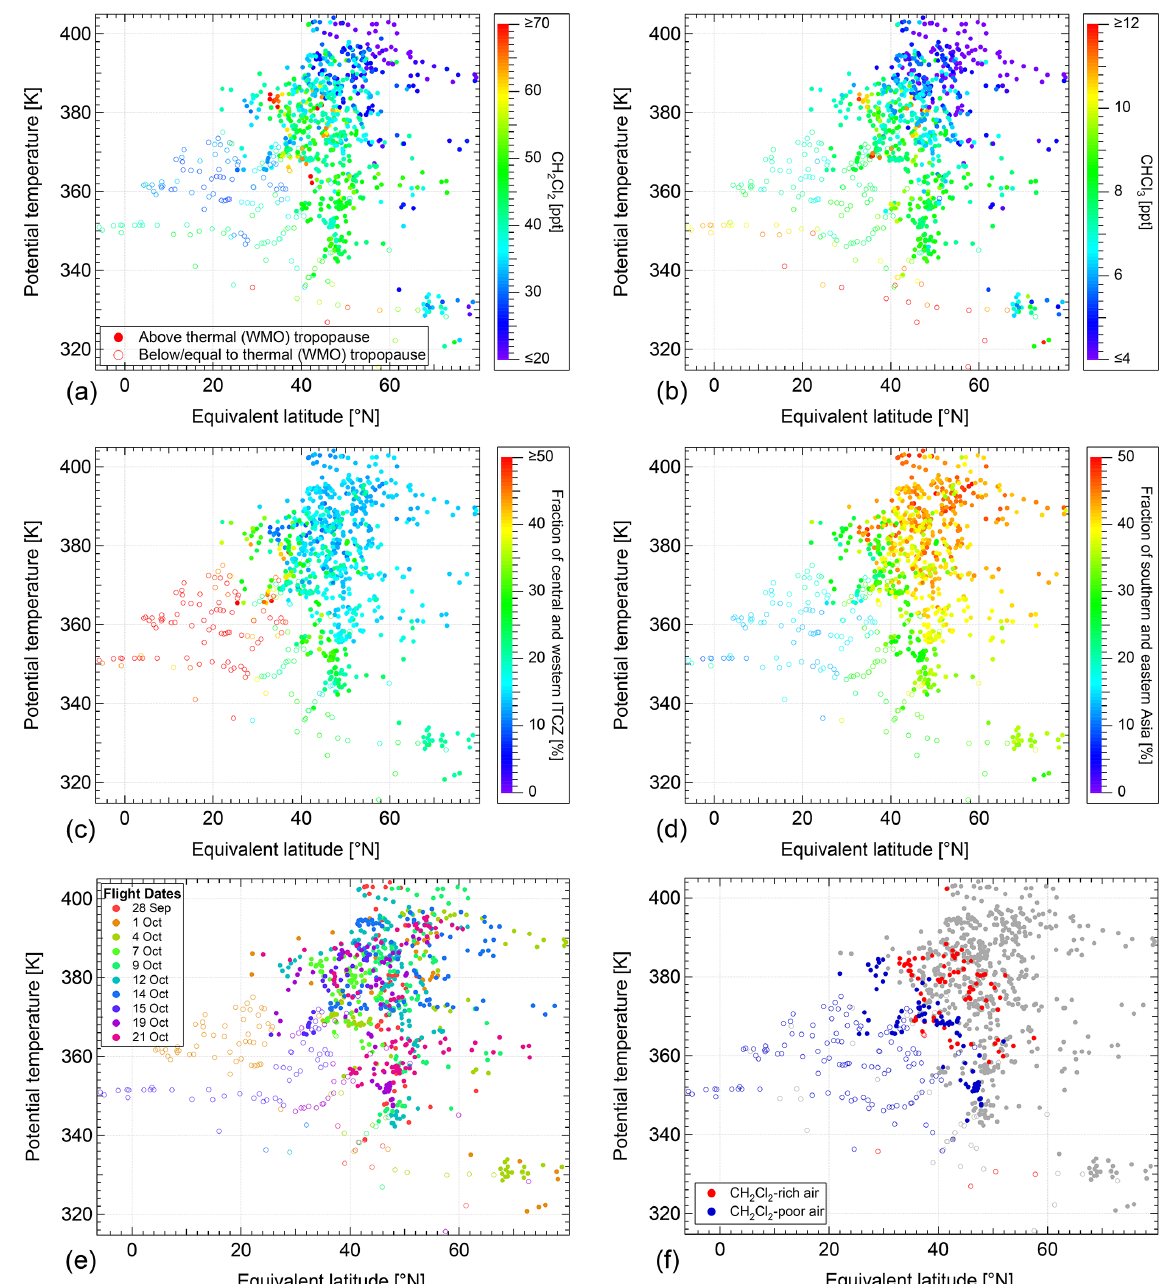
Figure 14. Measured (a, b) and simulated (c, d) tracers of the WISE flights (e) from 28 September to 21 October 2017, as a function of equivalent latitude and potential temperature. Note that equivalent latitudes ≤ 0 ◦ N are likely calculated artifacts due to a negative bias induced by convection (Pan et al., 2012). The open symbols indicate a measurement location below or equal to the thermal tropopause (TP), and filled symbols mark measurements located above the thermal TP. The coloration of panel (f) corresponds to the lower branch (blue) and to the upper branch (red) of the CH 2 Cl 2 –N 2 O relationship (referred to as CH 2 Cl 2 -poor and CH 2 Cl 2 -rich air, respectively; see Sect. 3.1.1). CH 2 Cl 2 -poor air measured at potential temperatures generally up to 375K mostly originated from the Central American as well as tropical Atlantic and northern African boundary layer (central and western ITCZ) and has mostly not (yet) entered the lower stratosphere at the time of measurement. CH 2 Cl 2 -rich air is strongly influenced by air masses from southern and eastern Asia and was measured almost exclusively in the extratropical lower stratosphere. Note that the fraction of surface origin tracers given in the graphs is not an absolute fraction of the whole air parcels but of the air masses younger than 6 months within the air parcels (see Sect. 3.1.2). The two different transport pathways from the boundary layer into the extratropical UTLS region are described in the